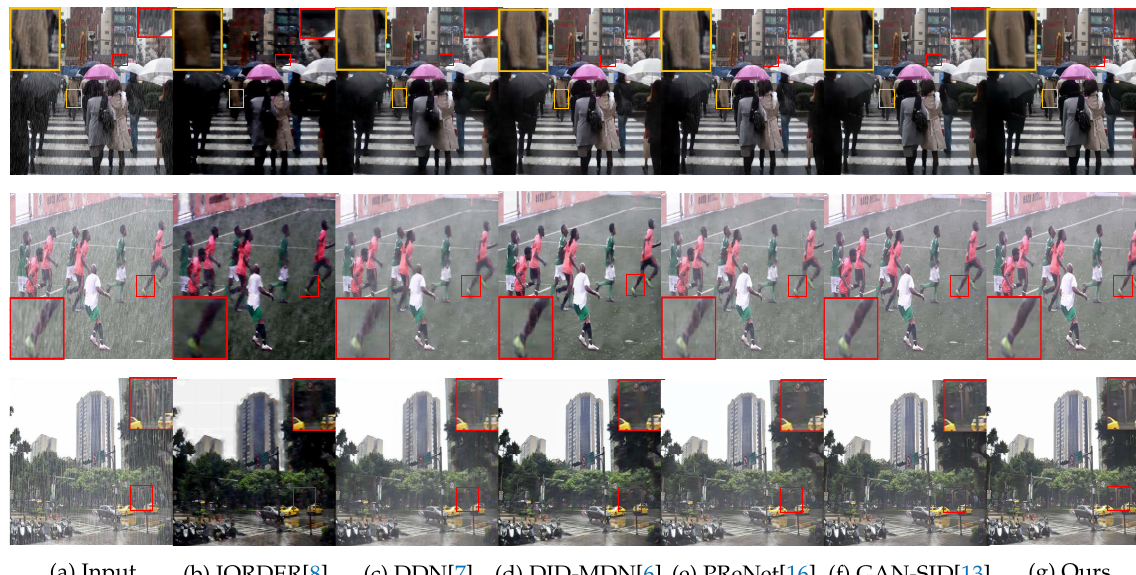
Figure 10. Visual comparison results on real-world